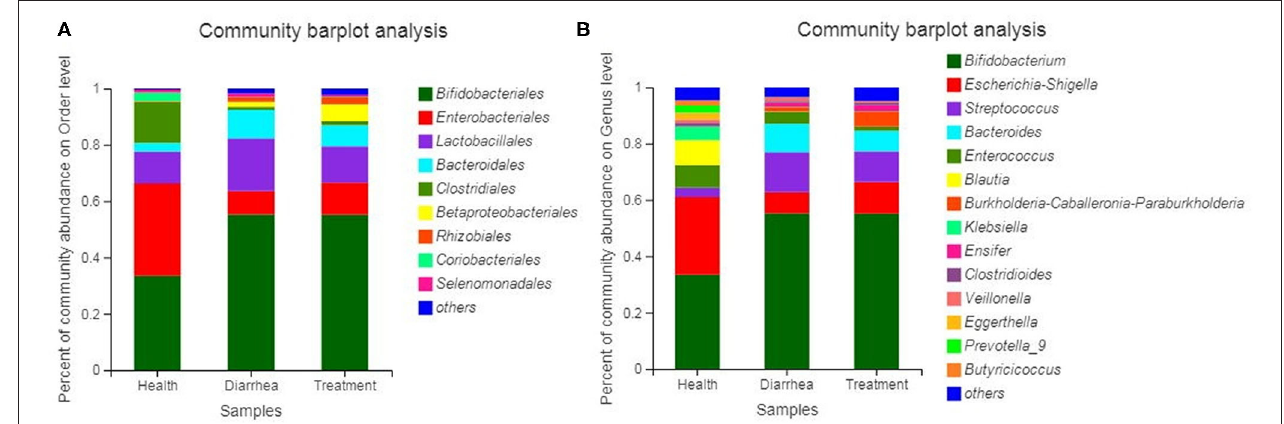
FIGURE 5 | Bacterial community and relative abundance, at the order (A) and genus (B) levels for all infant feces. Taxa with an abundance < 1% are included in